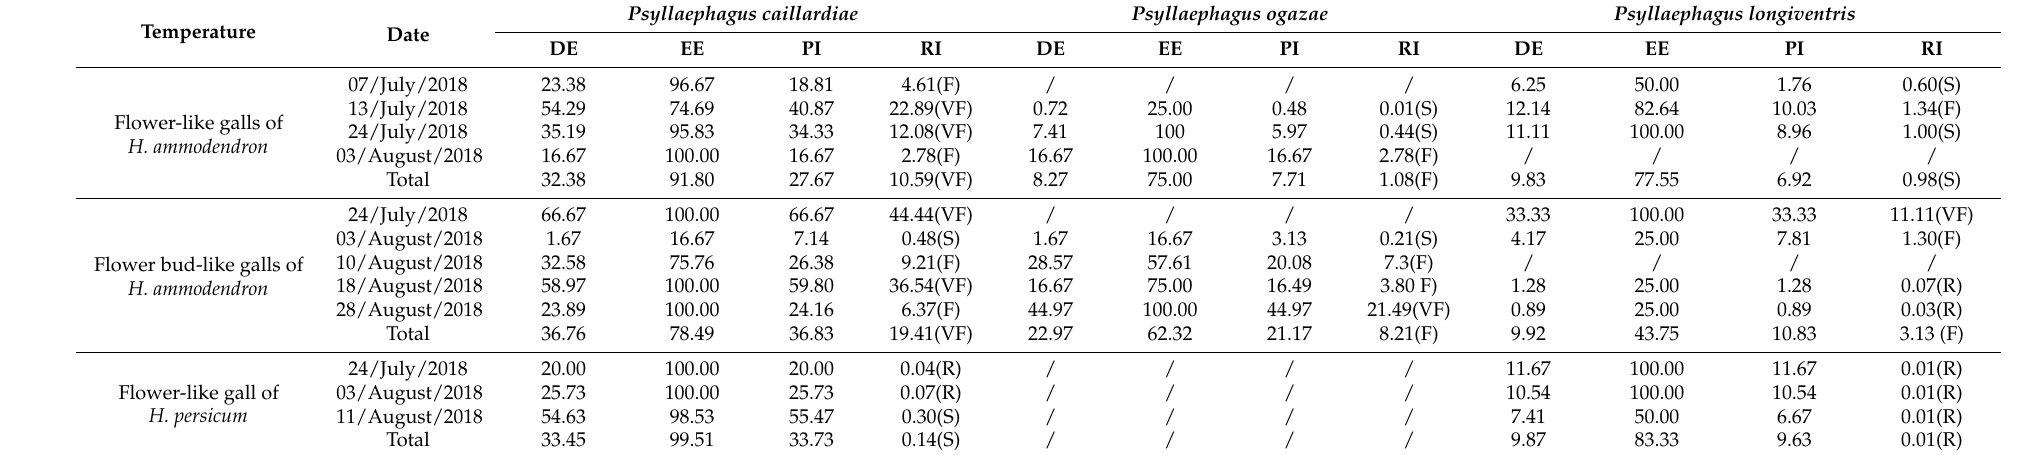
Table 3. Parasitization indexes and relative importance of the parasitoid species of flower-like galls on Haloxylon